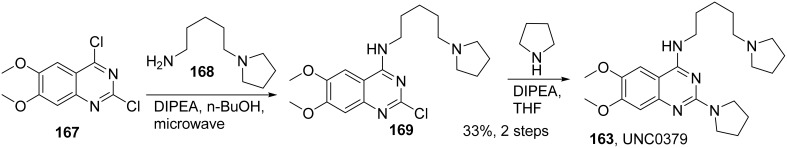
Synthesis of UNC0379 by Ma et al.